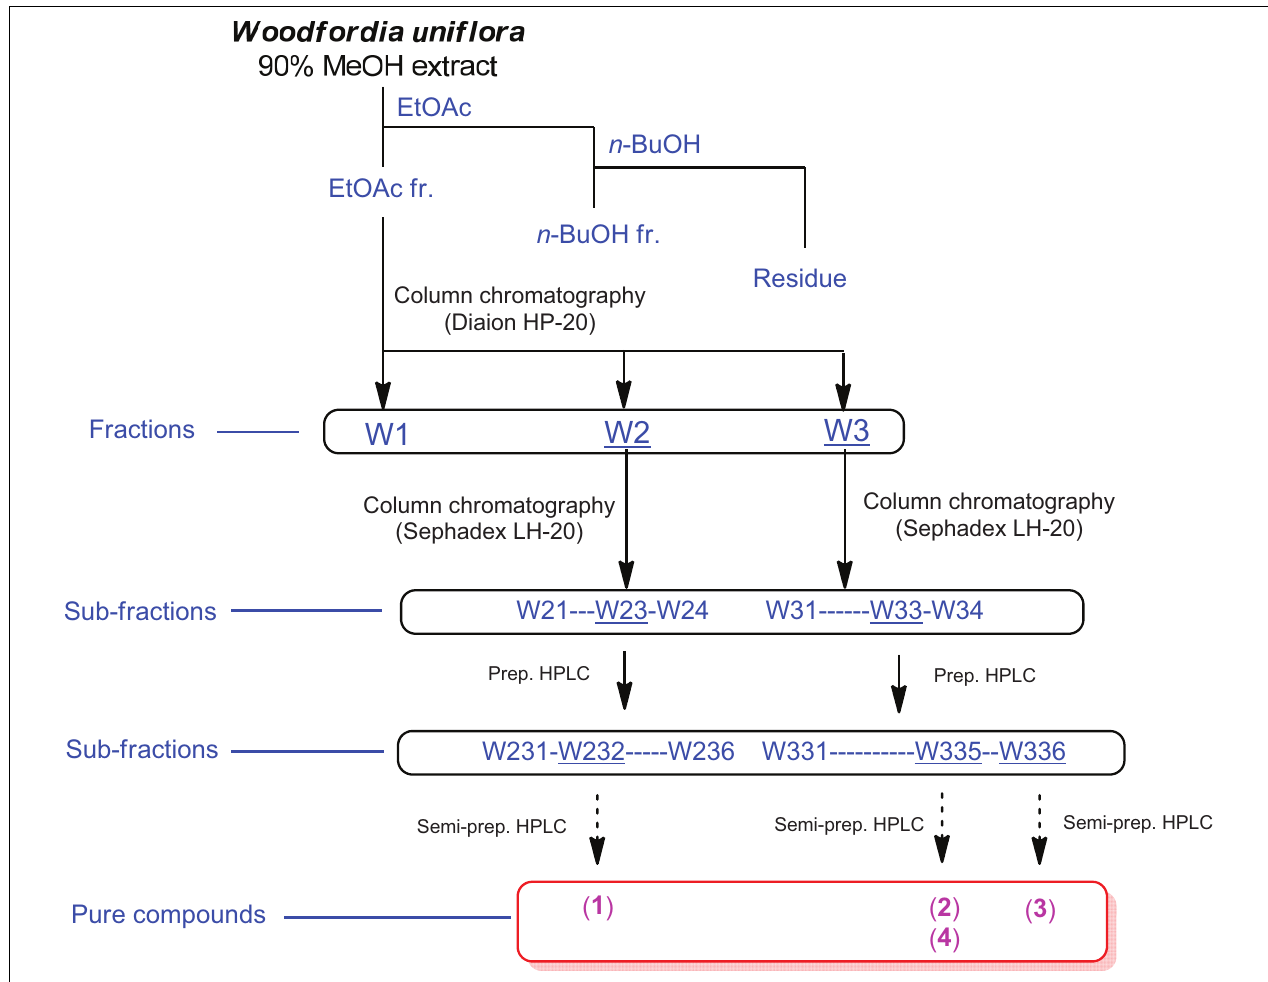
FIGURE 1 | Separation scheme of compounds 1–4